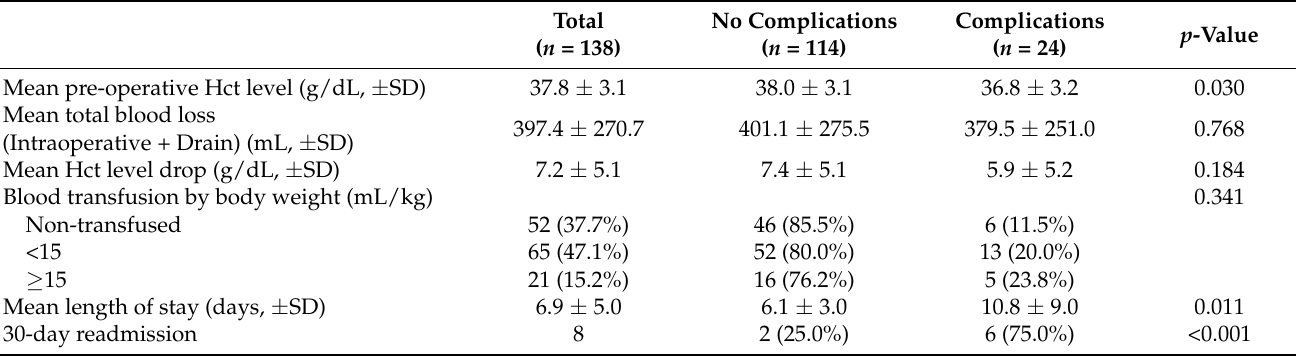
Table 2. Hematocrit level, blood transfusion by body weight, mean length of stay, and readmission of patients. Total